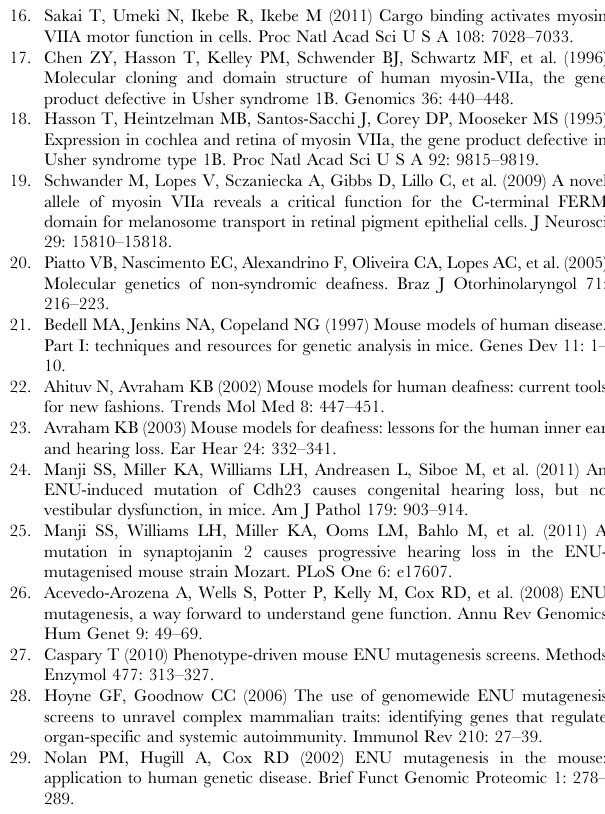
(TIF) Figure S5 SEM analysis of 4 week old cochlear sensory epithelium from Myo7a mutant strains. Apical, middle and basal cochlear turns were examined in Myo7a + / + (A, B and C), Myo7a I487N/I487N (D, E and F) and Myo7a F947I/F947I (G, H and I) mice at 4 weeks. OHC, outer hair cells; IHC, inner hair cells. Scale bar; 10 m M. (TIF) Table S1 Primer and enzymes used in genotyping assays.